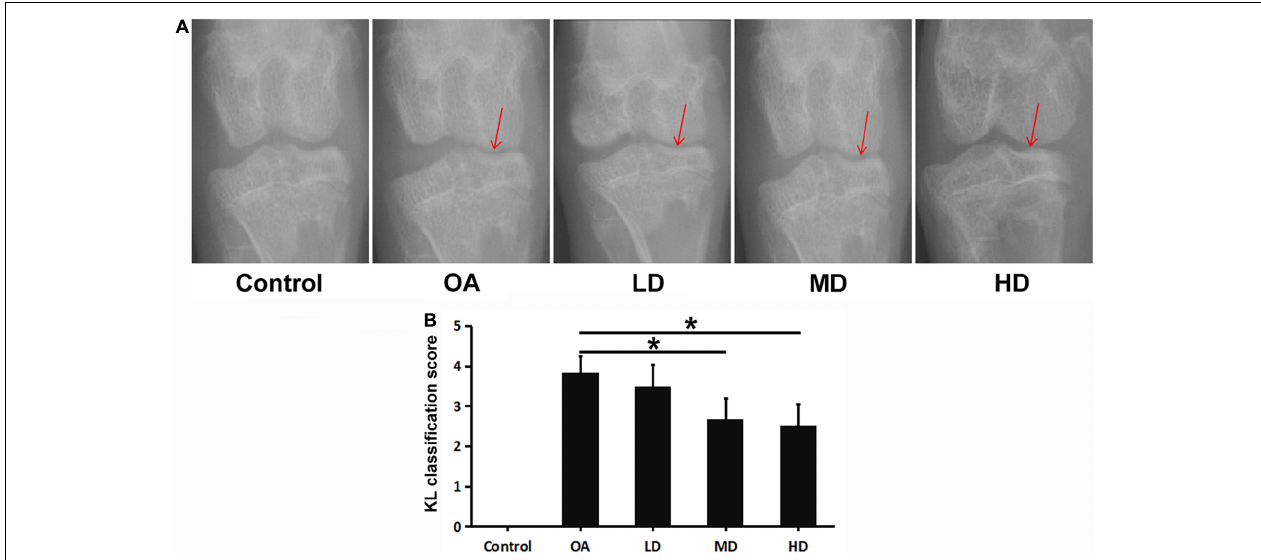
FIGURE 1 | X-ray of the knee in each group at 8 weeks after operation. Arrows showed the joint space narrowing and articular cartilage lesion of the knee joint. (A) X-ray of the knee in each group. (B) KL classification score of the knee in each group. * P < 0.05.